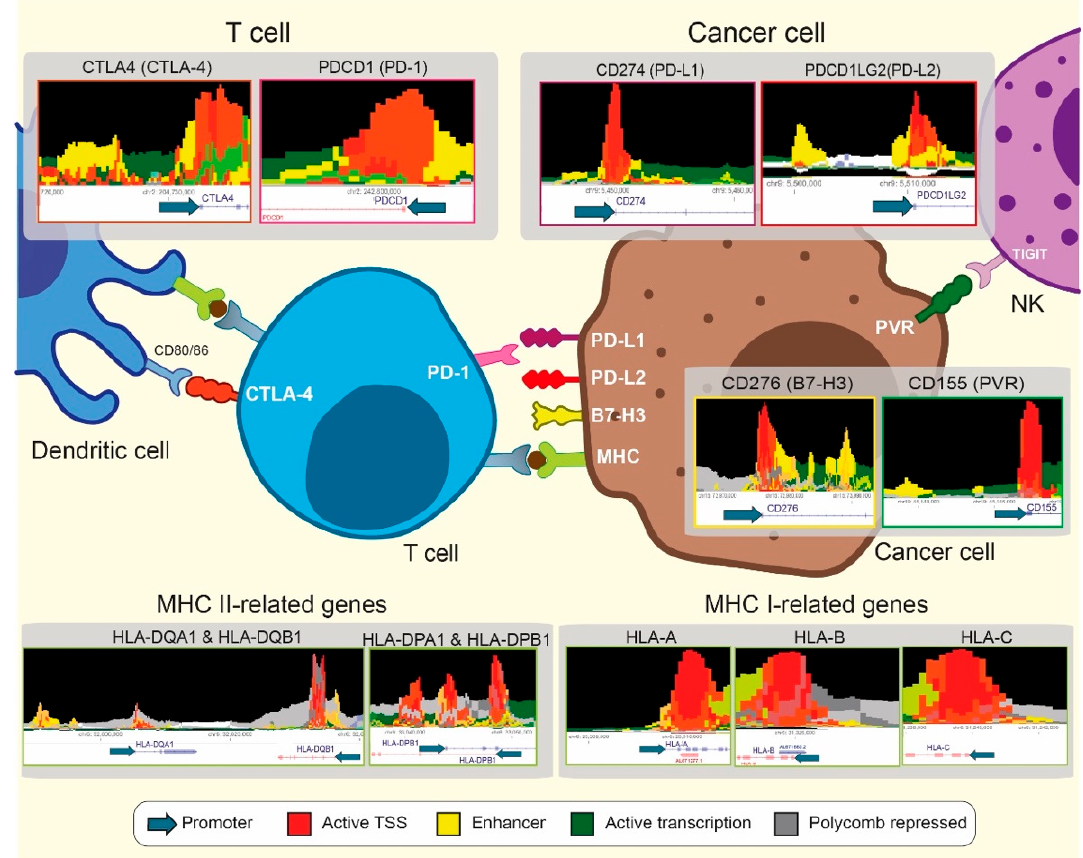
Figure 3. Therapeutic opportunities combining epigenetics and immunotherapy. Different GRE, including promoters and enhancers, have been identified close to the transcription start site (TSS) of IC-related genes using the Epilogos visualization tool (https://epilogos.altius.org/, accessed on 29 April 2021). A total of 127 human samples from the Roadmap Consortium were considered when cancer cell-expressing genes were interrogated. In contrast, the blood & T cells category was selected from T cell and NK expressing genes.